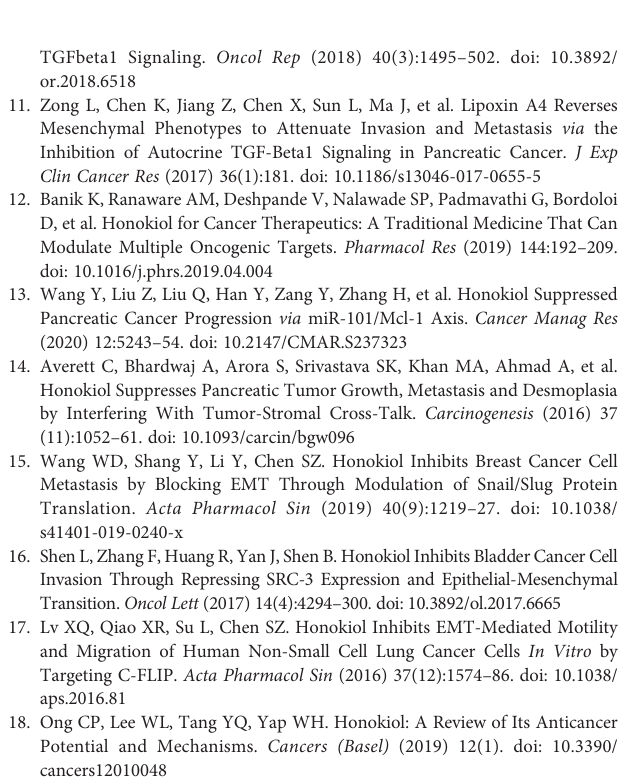
Supplementary Figure 1 | After the axons of the dorsal root ganglia grow, immuno fl uorescence staining the markers of S100 b , NF-200, TUJ1. Supplementary Figure 2 | The ability of tumor cells migrating to the dorsal root ganglion is evaluated by the invasion index ( a / g ), and the ability of dorsal root ganglion axons to grow toward tumor cells is evaluated by growth index( b / g ). Supplementary Figure 3 | Immuno fl uorescence was used to identify the KPC cell line via staining the markers of CK19 and Amylase. Supplementary Figure 4 | KPC and PANC-1cell lines were treated with different concentrationsofHNK(0,2.5,5,10,20,40 m M).MTTassayswereusedtoassessthe viability of pancreatic cancer lines at different time points (24h,48h,72h, and 96h). Supplementary Figure 5 | Fluorescence microscopy showed that KPC cells can migrate along the axon after contacting the axon of the dorsal root ganglion. Supplementary Video 1 | The live-cell imaging system was used to record the KPC cell line and the dorsal root